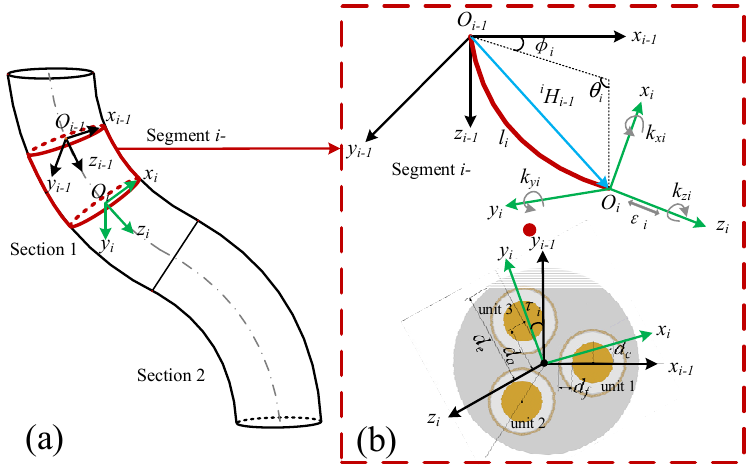
Figure 2. ( a ) Schematic diagram of the structure of two adjacent soft manipulators. ( b ) The shape parameters of the i-th segment of the soft manipulator and the coordinate transformation between two adjacent coordinate systems.